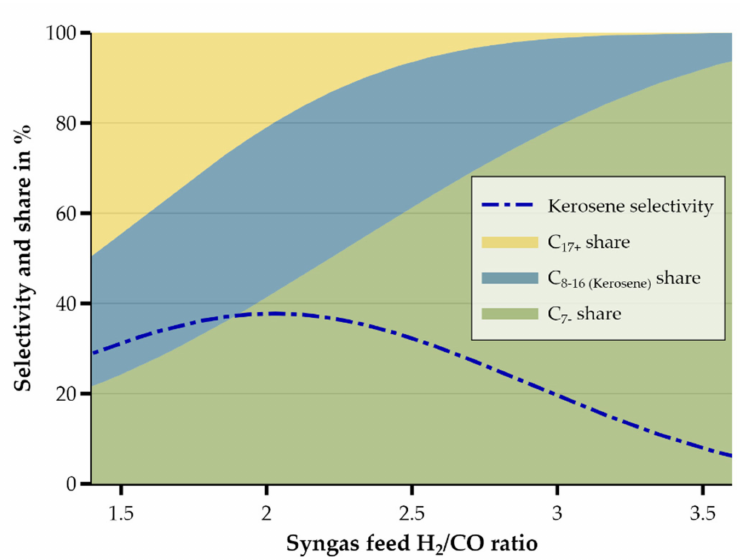
Figure 7. The syngas reactants ratio dependency on the selectivity shares and kerosene range selectivity for a fixed bed reactor with T = 220 ◦ C, p = 2.5 MPa, and GHSV = 5 NL/h/g cat